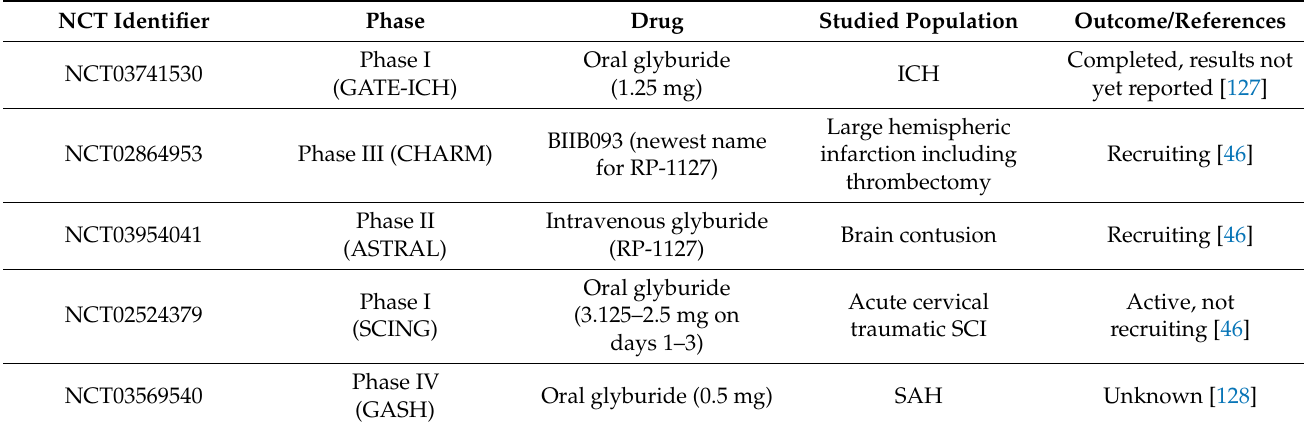
Table 3. Ongoing Clinical Trials for